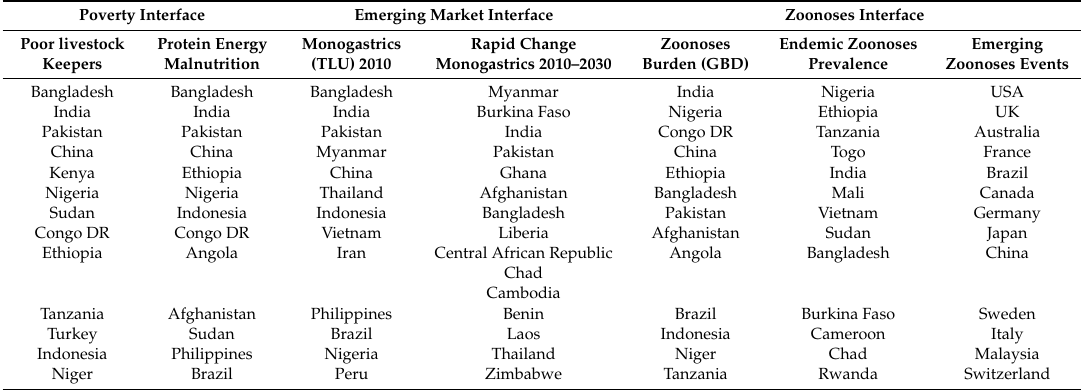
Table 4. Disease burdens associated with zoonoses (retrieved from